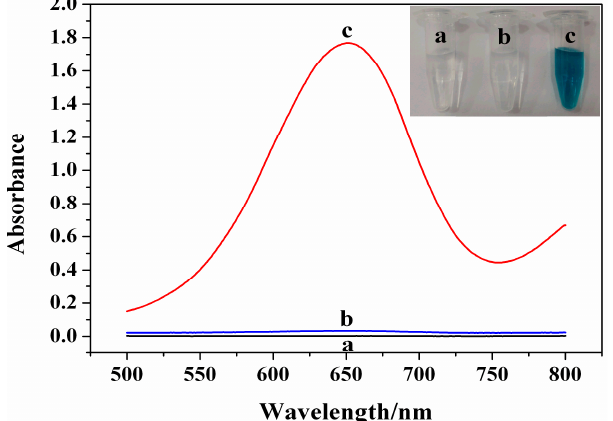
Figure 3. UV-VIS absorption spectrum of (a) TMB + H 2 O 2 ; (b) TMB + PtNPs and (c) TMB + H 2 O 2 + PtNPs (inset: the corresponding photographs).